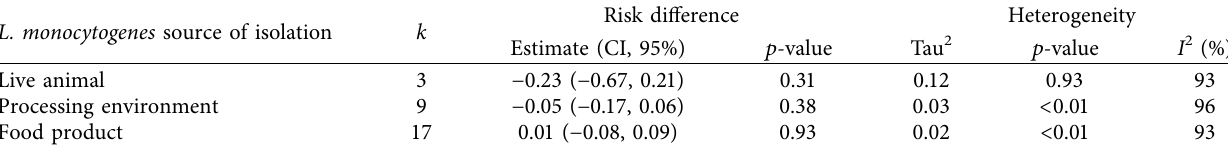
Table 4: Estimates and main statistics of the risk difference of antimicrobial resistance in Listeria monocytogenes by source of isolation. L. monocytogenes source of